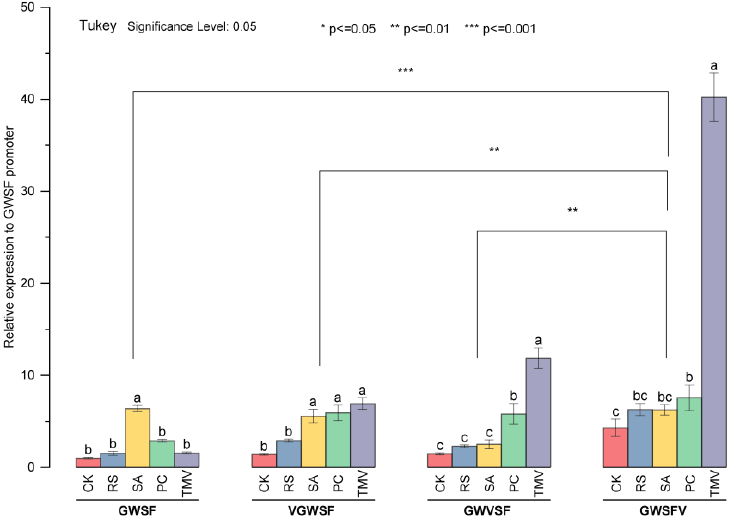
Figure 5. The relative expression levels of four promoters in E. urophylla . Leaf discs with transient expression were assayed for promoter activity by quantitative PCR. The basal transcriptional level of the original GWSF, namely the CK in the GWSF group, was normalized to 1. CK: basal transcription level of the corresponding promoter; SA: salicylic acid; RS: Ralstonia solanacearum ; PC: Phytophthora capsici ; and TMV: tobacco mosaic virus. The experiments were performed at least three times with similar results. The values of the bars are mean values. In the figure, different small letters indicate that different treatments in the same promoter group differ significantly at the level of 0.05. In the upper part of the figure, ** and *** indicate significant differences among the promoter groups at the level of 0.01, and 0.001, respectively. The statistics identified above are based on the Tukey test.